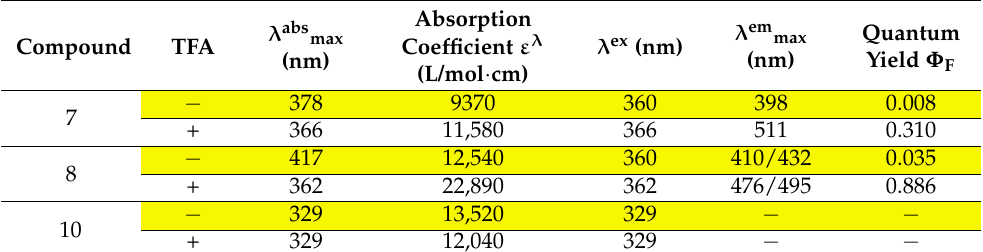
Table 1. Low-energy (red-shifted) absorption wavelengths ( λ absmax ), corresponding absorption coefficients ( ε ), excitation wavelengths ( λ ex ), emission maxima ( λ emmax ), and fluorescence quantum yields Φ F of ( 7 ), ( 8 ), and ( 10 ) without ( − ) and with (+) 500 eq. of TFA. The data highlighted in yel- low are from the experiments without acid added.